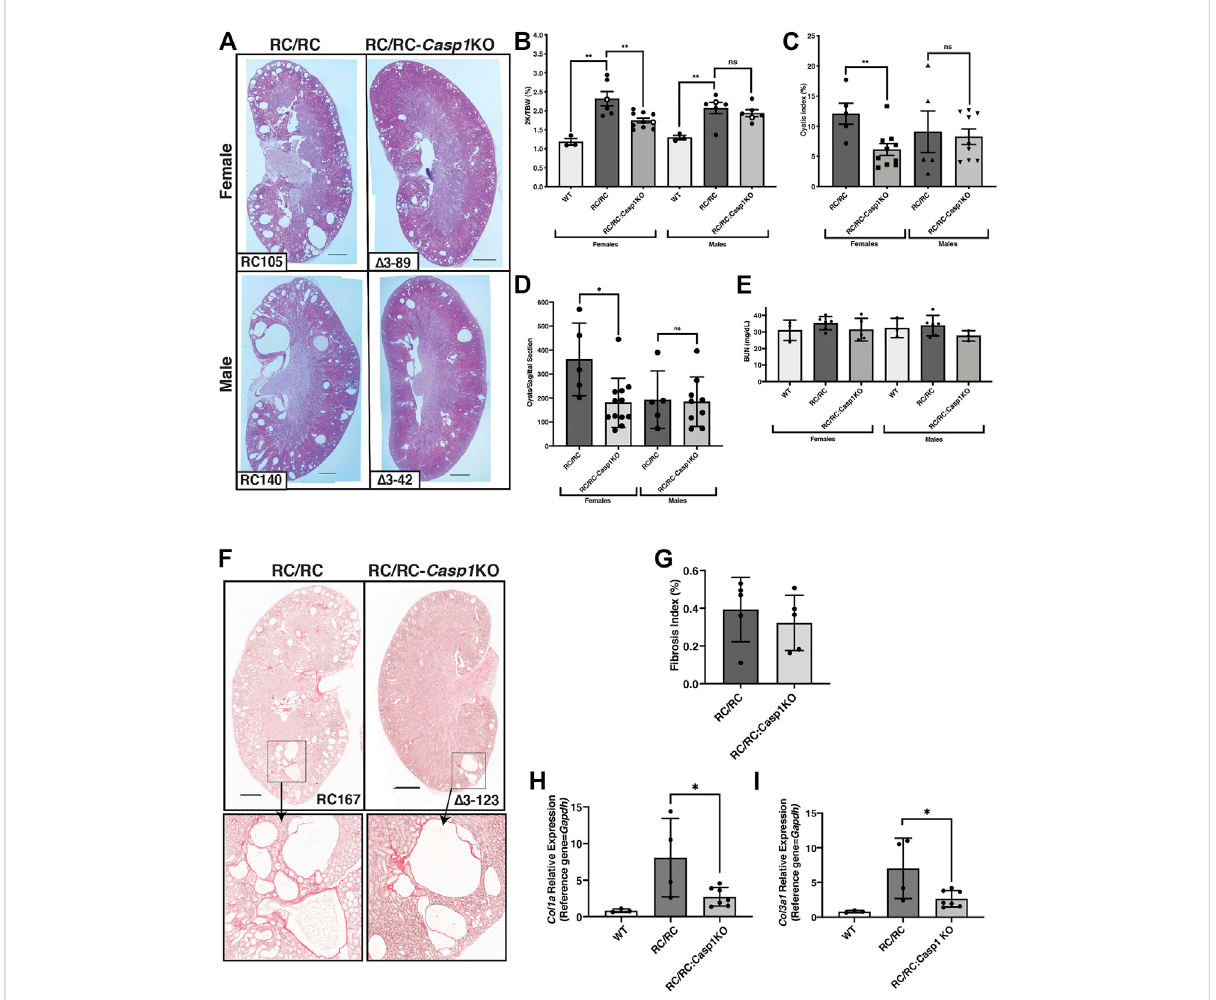
Casp1 -de fi ciency restrains cystic disease progression infemale RC/RCmice. (A) Formalin- fi xed average sized kidneys from6 mold RC/RCand RC/RC: Casp1 KOmiceweresectionedandstainedwithhematoxylinandeosin.Scalebars=1 mm. (B) Thetwo-kidney/totalbodyweightpercentage (2K/TBW %) was determined for each animal analyzed and plotted as a function of genotype for females and males. Open symbols indicate data pointsfromthosemicefromwhichtheH&Eimagesshownin (A) weretaken.Thecysticindex (C) andthenumberofcystspersagittalsection (D) for RC/RC and RC/RC: Casp1 KO mice were determined and plotted as a function of gender and genotype. (E) Blood urea nitrogen (BUN) was determined for each mouse tested and plotted as a function of gender and genotype. (F) Sections from kidneys of female RC/RC and RC/RC: Casp1KO mice were stained with picrosirius red and illuminated by bright fi eld to visualize collagen type I- α 1 ( Col1 α 1 ) and collagen type III- α 1 ( Col3 α 1 ). Scale bars = 1 mm. Enlarged images of the boxed regions are shown below as indicated by the arrows. (G) The fi brosis index was determined from picrosirius red-stained kidney sections from the RC/RC and RC/RC: Casp-1 KO female mice. Quantitative RT-PCR of RNA isolated from WT, RC/RC, and RC/RC: Casp-1 KO female mice, showing the relative expression of the fi brosis markers Col1 α 1 (H) and Col3 α 1 (I)